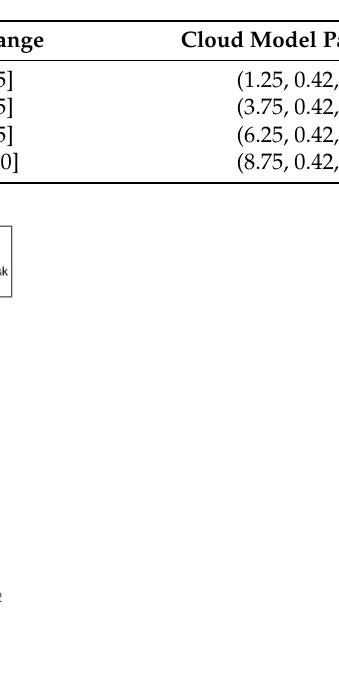
Table 4. Standard Grade and Cloud Model Parameters.